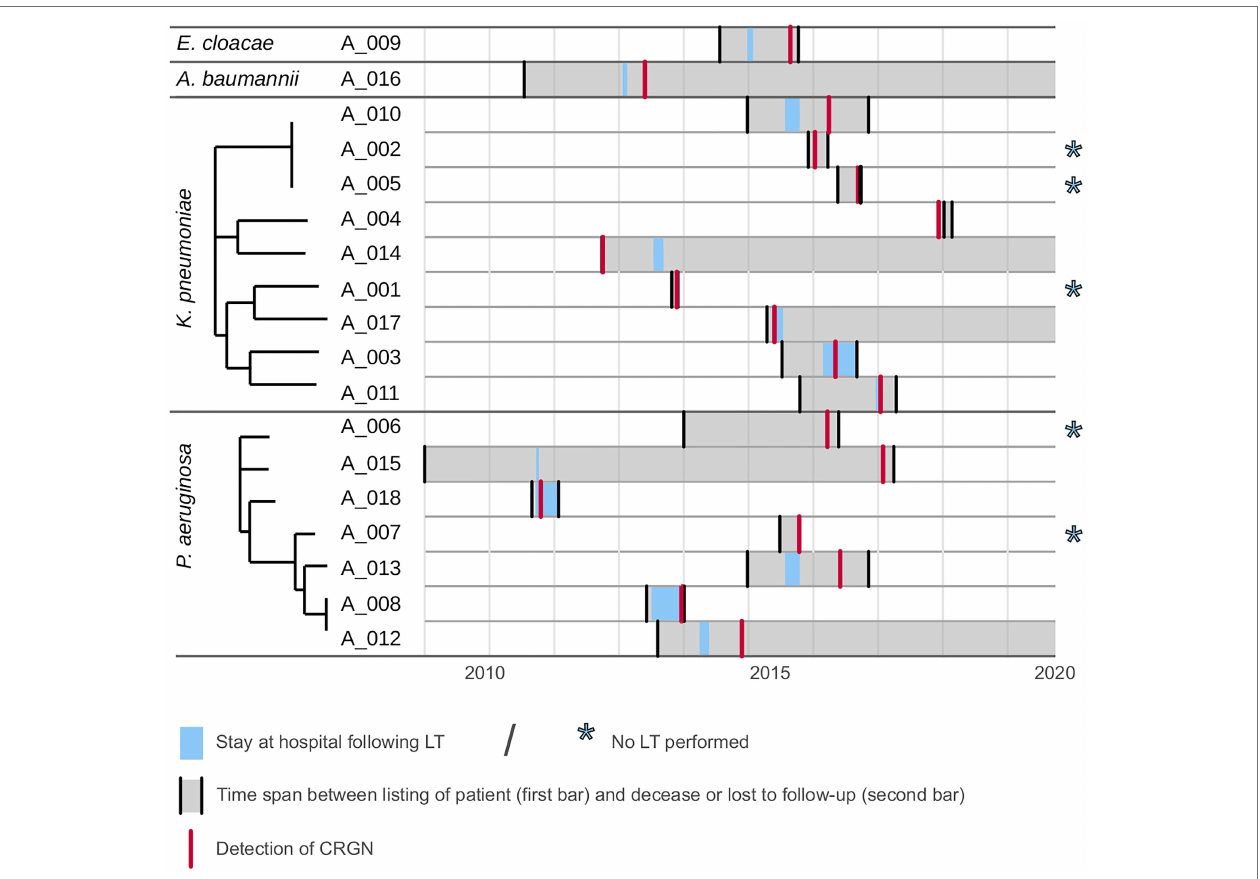
FIGURE 2 | Timeline plot for patients with CRGN listed for LT. Depicted as gray areas are the time span from listing for LT until loss to follow-up or decease for each patient for which a CRGN was detected. Light blue areas within represent the stay at Frankfurt University hospital following LT. Red bar marks the initial CRGN